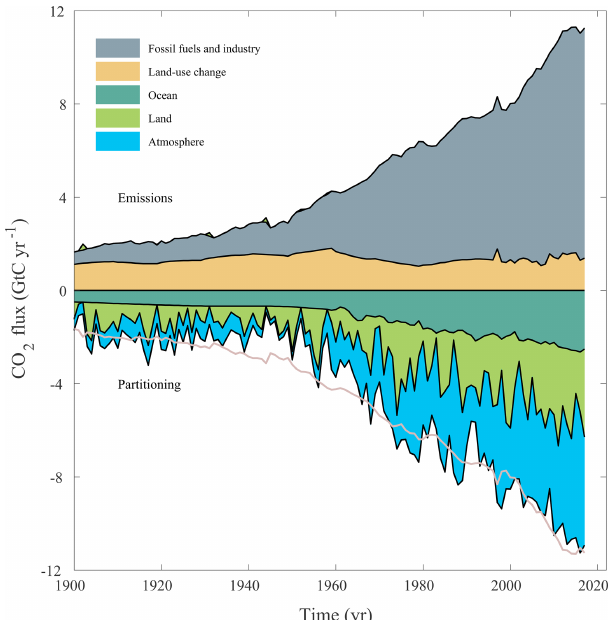
Figure 3. Combined components of the global carbon budget il- lustrated in Fig. 2 as a function of time, for fossil CO 2 emissions ( E FF ; grey) and emissions from land-use change ( E LUC ; brown), as well as their partitioning among the atmosphere ( G ATM ; blue), ocean ( S OCEAN ; turquoise), and land ( S LAND ; green). The parti- tioning is based on nearly independent estimates from observations (for G ATM ) and from process model ensembles constrained by data (for S OCEAN and S LAND ) and does not exactly add up to the sum of the emissions, resulting in a budget imbalance, which is repre- sented by the difference between the bottom pink line (reflecting total emissions) and the sum of the ocean, land, and atmosphere. All time series are in GtCyr − 1 . G ATM and S OCEAN prior to 1959 are based on different methods. E FF values are primarily from Boden et al. (2017), with uncertainty of about ± 5% ( ± 1 σ ); E LUC values are from two bookkeeping models (Table 2) with uncertainties of about ± 50%; G ATM prior to 1959 is from Joos and Spahni (2008) with uncertainties equivalent to about ± 0 . 1–0.15GtCyr − 1 and from Dlugokencky and Tans (2018) from 1959 with uncertainties of about ± 0 . 2GtCyr − 1 ; S OCEAN prior to 1959 is averaged from Khatiwala et al. (2013) and DeVries (2014) with uncertainty of about ± 30% and from a multi-model mean (Table 4) from 1959 with uncertainties of about ± 0 . 5GtCyr − 1 ; S LAND is a multi-model mean (Table 4) with uncertainties of about ± 0 . 9GtCyr − 1 . See the text for more details of each component and their